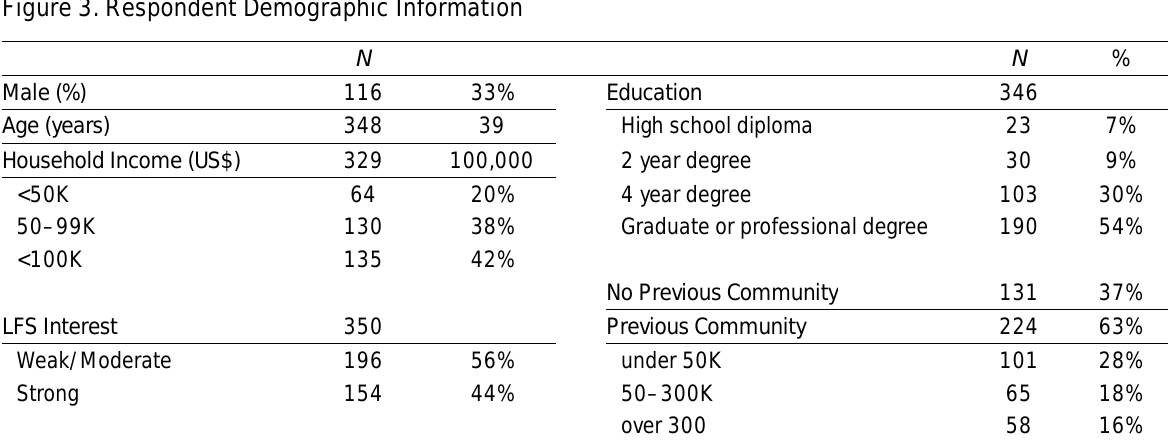
Figure 3. Respondent Demographic